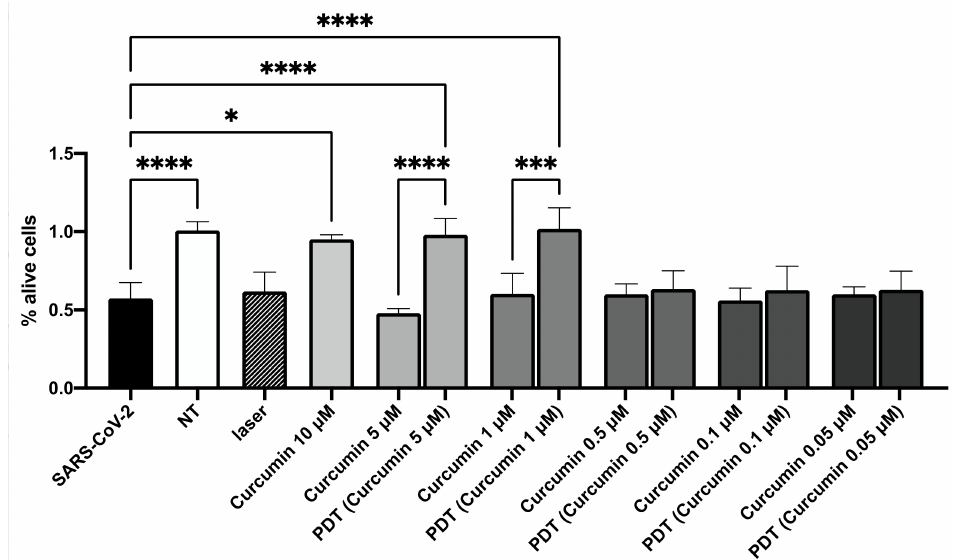
Figure 5. Viability at 7 days of the cells inoculated with curcumin-treated virus (indicated as 2cur- cumin”), PDT-treated virus (indicated as “PDT curcumin”), or untreated virus (indicated as “SARS- CoV-2”). Non-infected cells (indicated as NT) and cells infected with irradiated virus without curcumin (indicated as “laser”) are also shown. The data are presented as a percentage of living cells relative to the non-treated cells (NT). Results from Kruskal–Wallis test, adjusted for Dunn’s multiple comparisons test, are displayed. **** p -value < 0.0001; *** p -value < 0.001; * p -value <